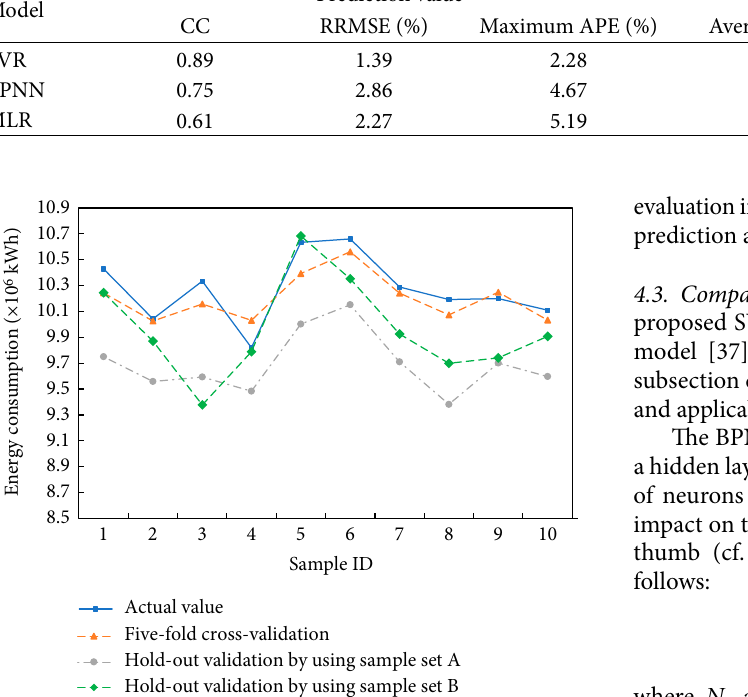
Figure 9: Comparison of different validation